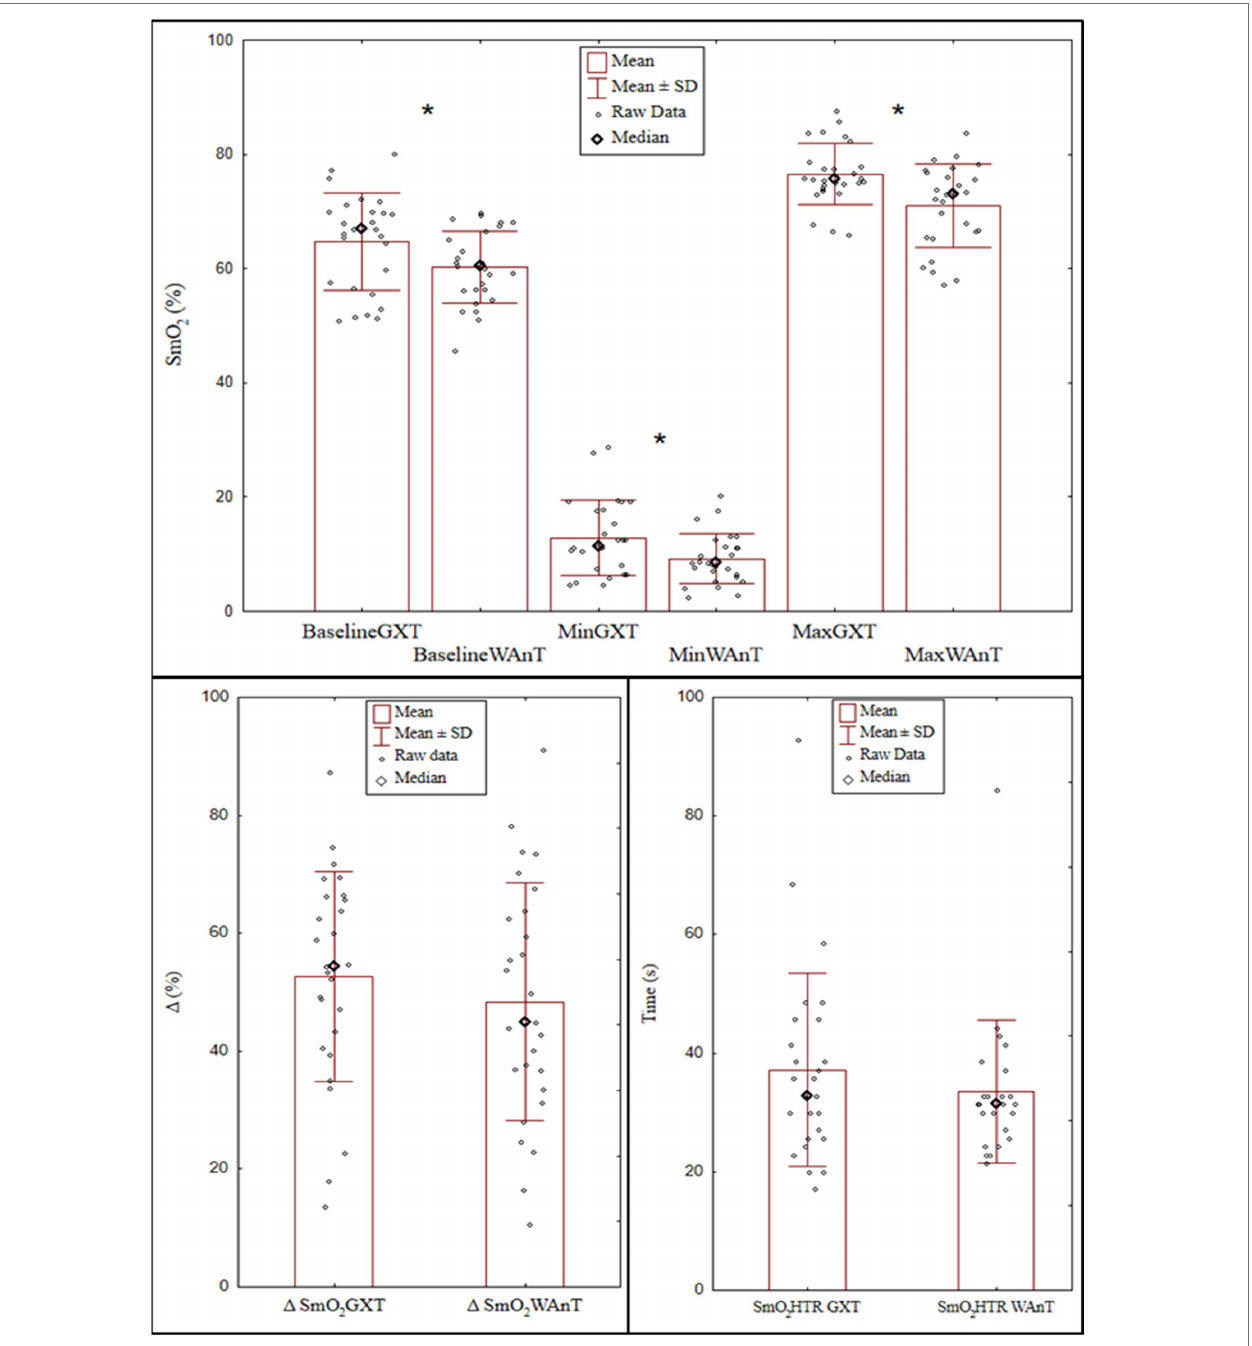
FIGURE 1 | Muscle oxygen saturation (SmO 2 ): at baseline, as exercise minimum values, post exercise maximum values, differences between baseline and minimum values ( Δ SmO 2 ) and half time for SmO 2 to reach the maximal value (SmO 2 HTR) during the graded exercise test (GXT) and the Wingate test (WAnT) in the combined group female and male speed skaters ( n = 27). *Mann-Whitney U test ( p <